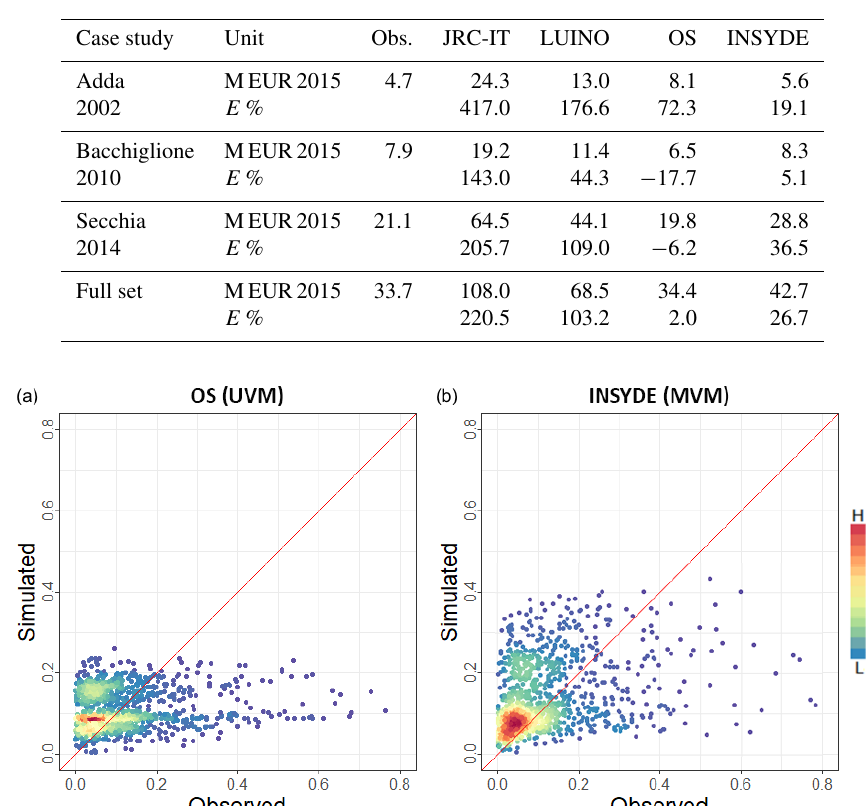
Table 3. Estimates and error from literature models compared to observed damage. Monetary values are in MEUR. E % is total percentage error.